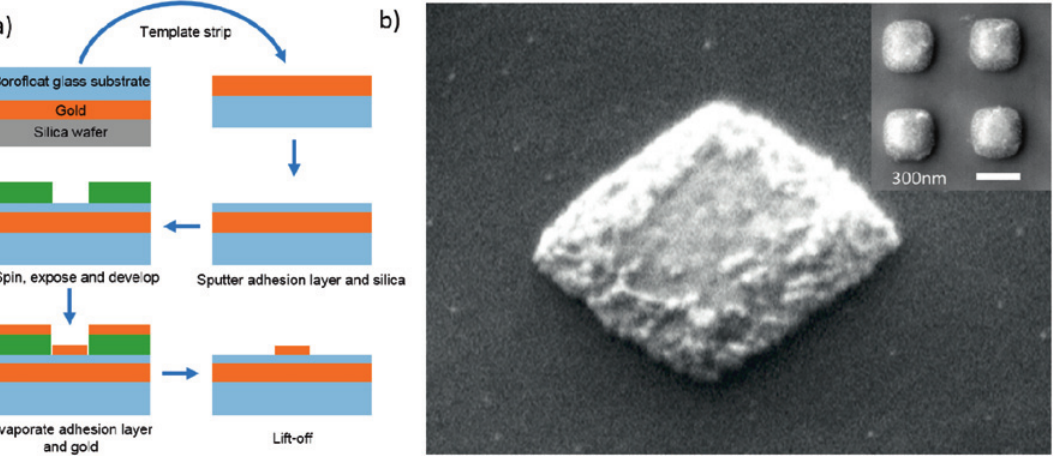
Figure 2: Fabrication of the MIM resonators. (a) Schematic of the fabrication process showing key steps. Adhesion layers are omitted for clarity. (b) SEM micrographs of the fabricated structures of 300 nm